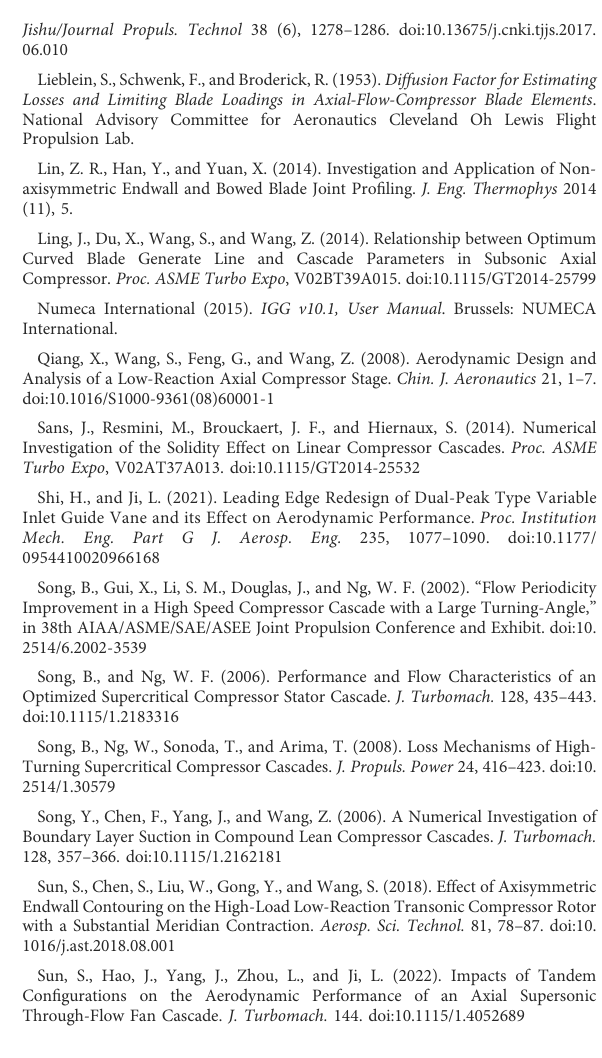
(G) α =20 ° , i =1 ° ; (H) α =20 ° , i =2 ° ; (I) α =20 ° , i =3 ° ; (J) α =30 ° , i =1 ° ; (K) α = 30 ° , i = 2 ° ; (L) α = 30 ° , i = 3 ° . SUPPLEMENTARY FIGURE S27 In fl uence of dihedral angle on incidence characteristics of total pressure loss coef fi cient with a camber angel of 50 ° ( h/b = 1, Ma = 0.8, σ = 1.8). SUPPLEMENTARY FIGURE S28 In fl uence of dihedral angle on the spanwise distribution of total pressure loss coef fi cient across the trailing edge at the incidence angle of 0.5 ° ( h/ b = 1, Ma = 0.8, θ = 50 ° , σ = 1.8). SUPPLEMENTARY FIGURE S29 Radial pressure gradient and surface limiting streamlines on the suction surface,transversepressuregradient and surfacelimiting streamlineson theendwall,andthedistributionoftotalpressurelosscoef fi cientacross thetrailingedge( h/b =1, σ =1.8, θ =50 ° ) (A) α =0 ° , i =0 ° ; (B) α =20 ° , i =0 ° ; (C) α =30 ° , i =0 ° ; (D) α =0 ° , i =0.1 ° ; (E) α =20 ° , i =0.1 ° ; (F) α =30 ° , i =0.1 ° ; (G) α =0 ° , i =0.25 ° ; (H) α =20 ° , i =0.25 ° ; (I) α =30 ° , i =0.25 ° ; (J) α =0 ° , i = 0.5 ° ; (K) α = 20 ° , i = 0.5 ° ; (L) α = 30 ° , i = 0.5 ° ; (M) α = 0 ° , i = 0.7 ° ; (N) α = 20 ° , i = 0.7 ° ; (O) α = 30 ° , i = 0.7 ° .